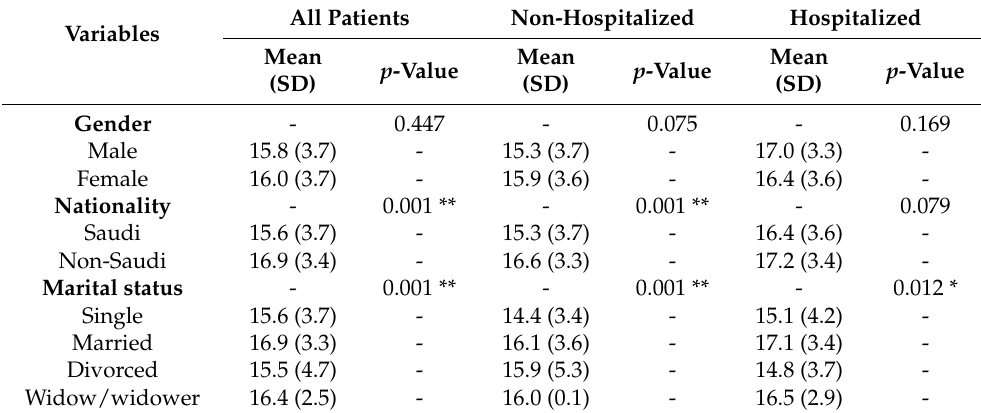
Table 3. Healthy diet score by basic demographical characteristics of respondents.